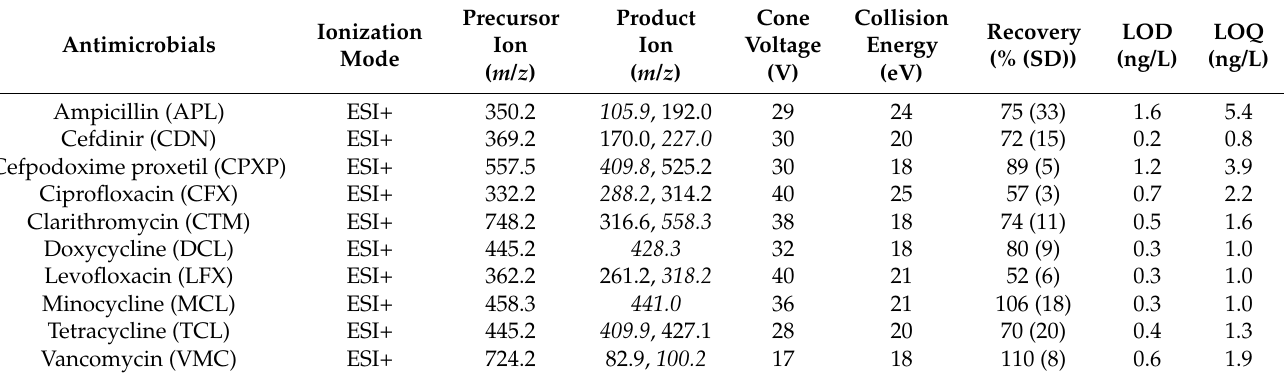
Table 2. LC–MS/MS parameters and validations of each antimicrobial.